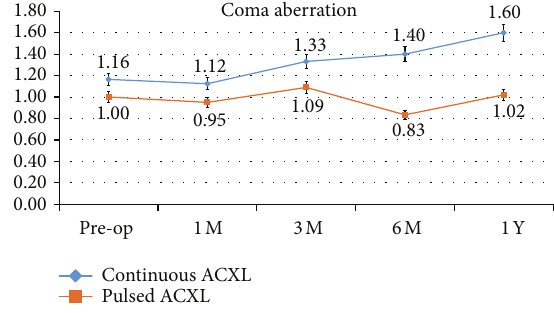
Figure 5: Coma values showed a statistically not significant difference one year after treatment. Continuous light accelerated crosslinking (blue line) was associated with a slight statistically not significant change of the coma by a mean value of +0.44 𝜇 m, while pulsed light treatment (orange line) showed a stable value during the follow-up.